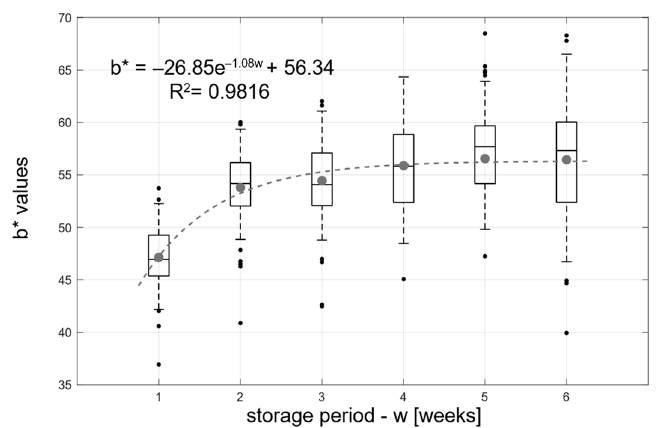
Figure 4. Effect of ambient temperature on a* values of apples during storage: the red color parameter increases to a specific limit.